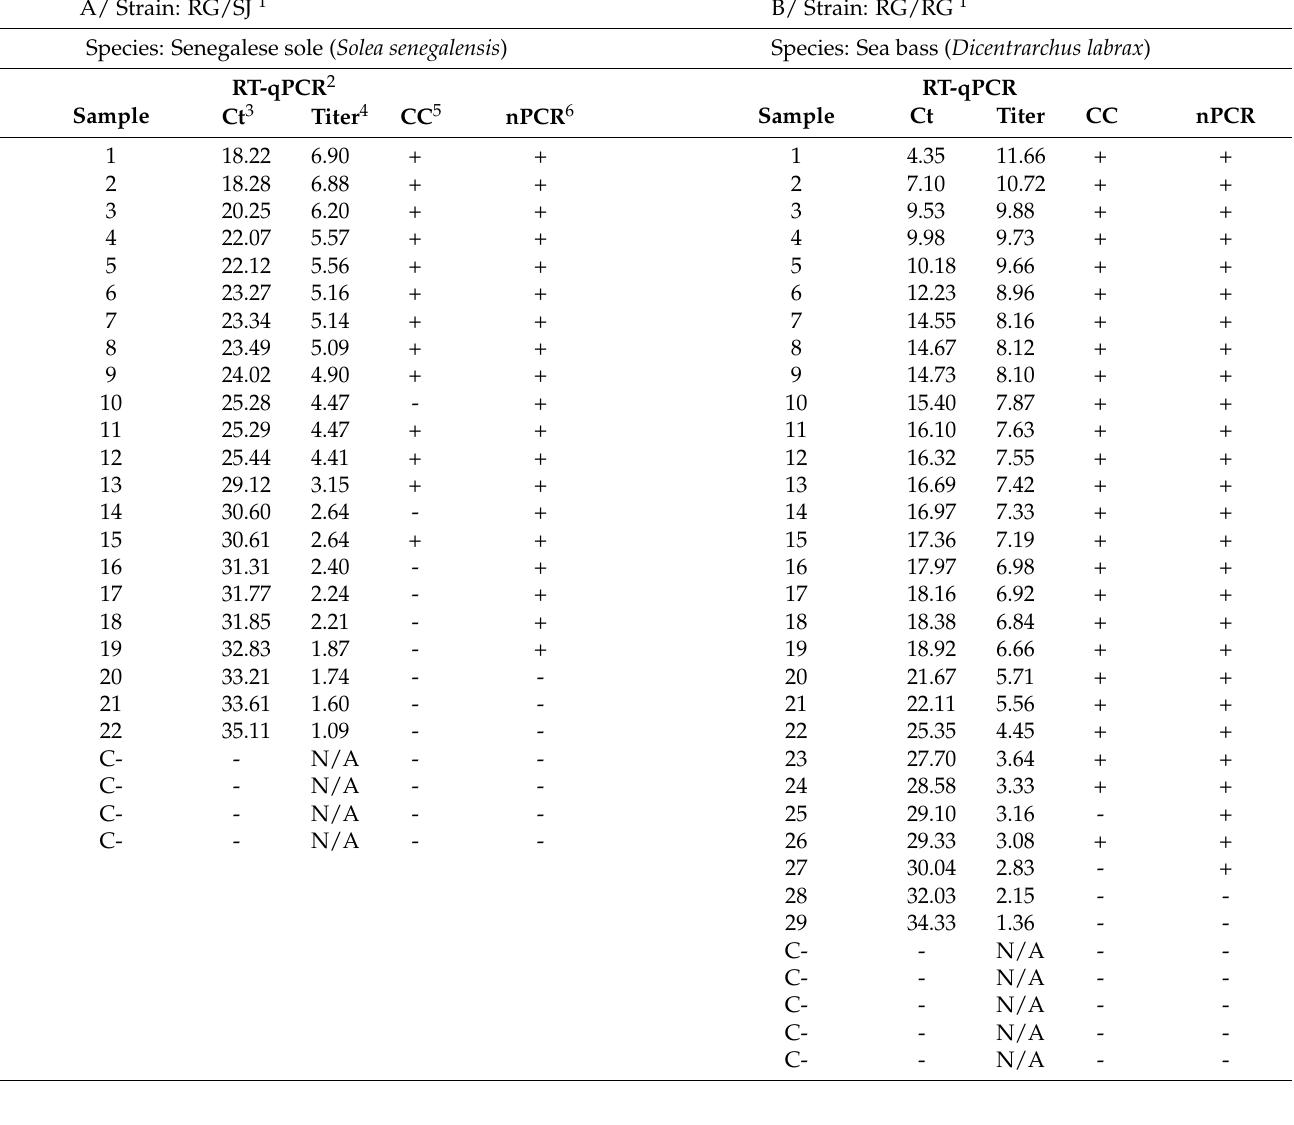
Table 8. Experimentally infected fish: diagnostic characteristics of the viral diagnosis by RT-qPCR, nPCR, and cell culture